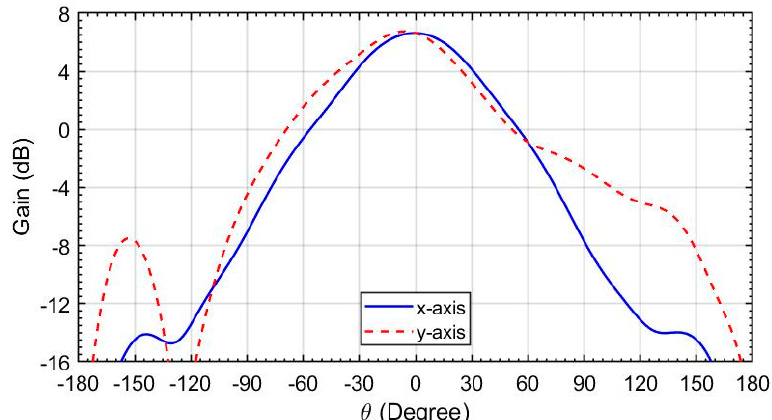
Figure 7. Simulated pattern of the proposed antenna.